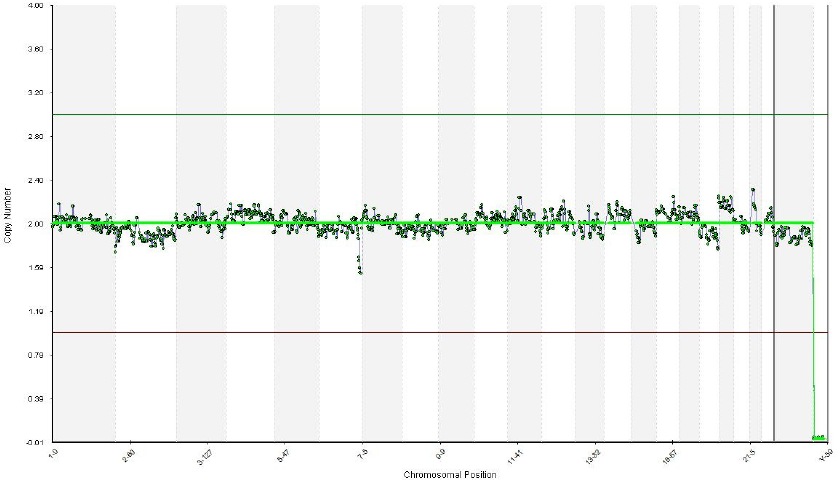
Figure 3. Preimplantation genetic screening results from NGS analysis of the embryo transferred. The x-axis indicates the chromosome numbers (1–22, X and Y) and the y-axis indicate the chromosome copy number assignments.